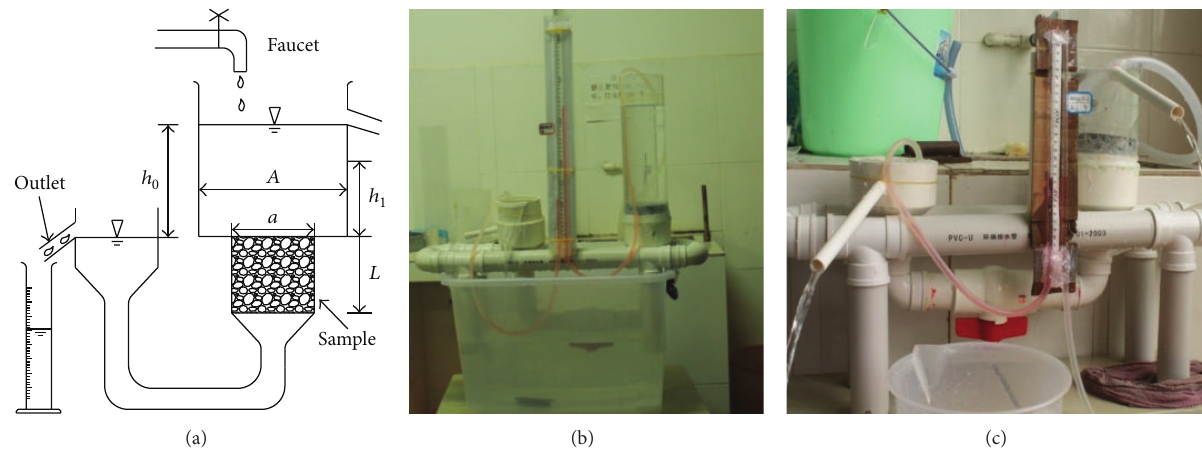
Figure 2: Apparatuses used to measure the permeability of pervious concrete: (a) schematic outline, (b) falling water head setup, and (c) constant water head